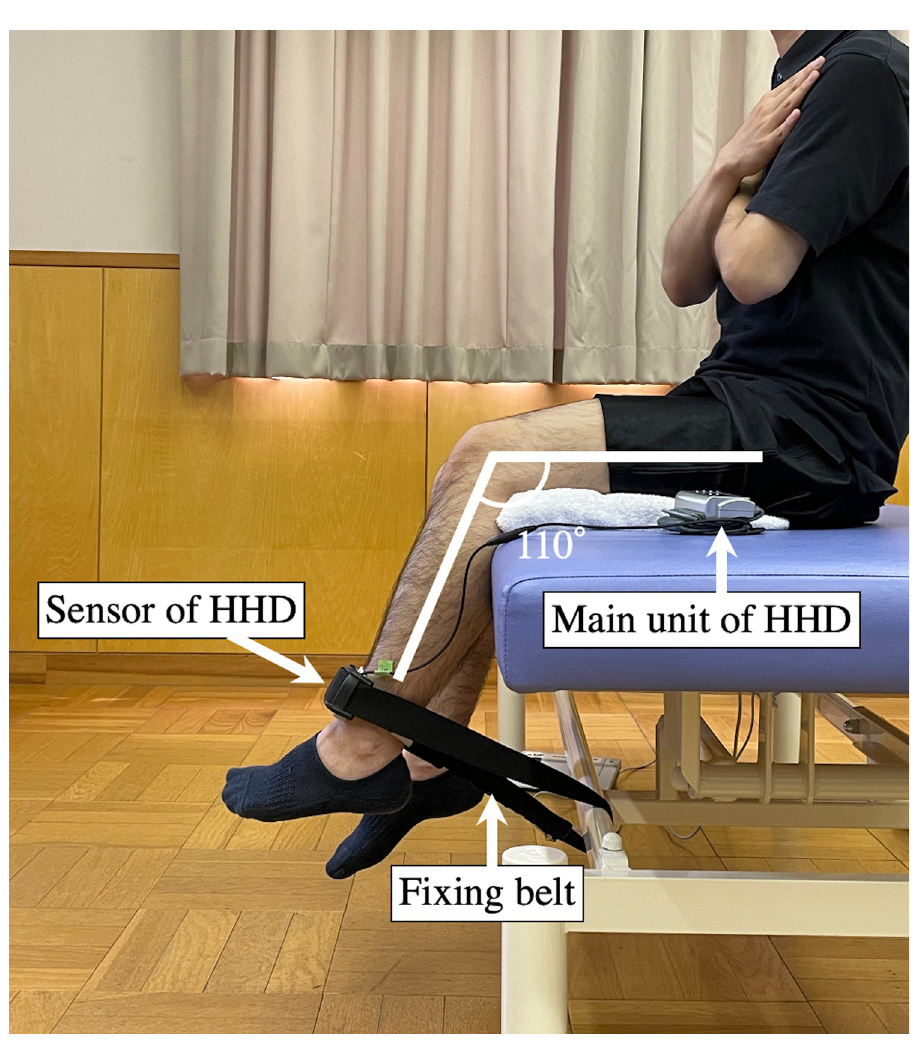
Fig 2. Experimental setup for measuring the quadriceps muscle